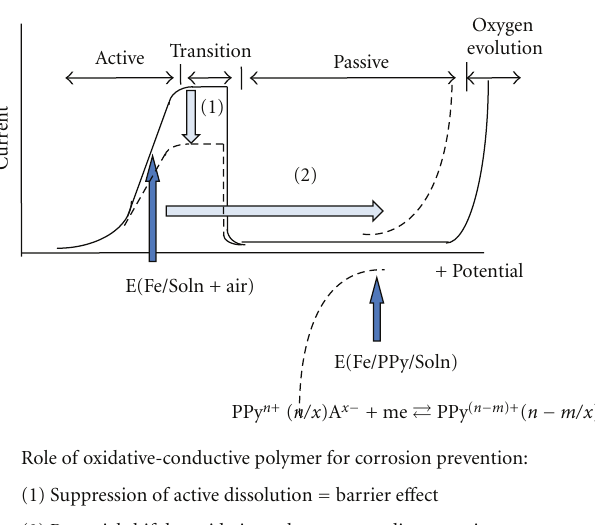
Figure 4: Potential-current relation of steels covered by oxidative conducting PPy. A barrier e ff ect of PPy suppresses active dissolution of the steel and an oxidative property of PPy shifts the potential into passive state.